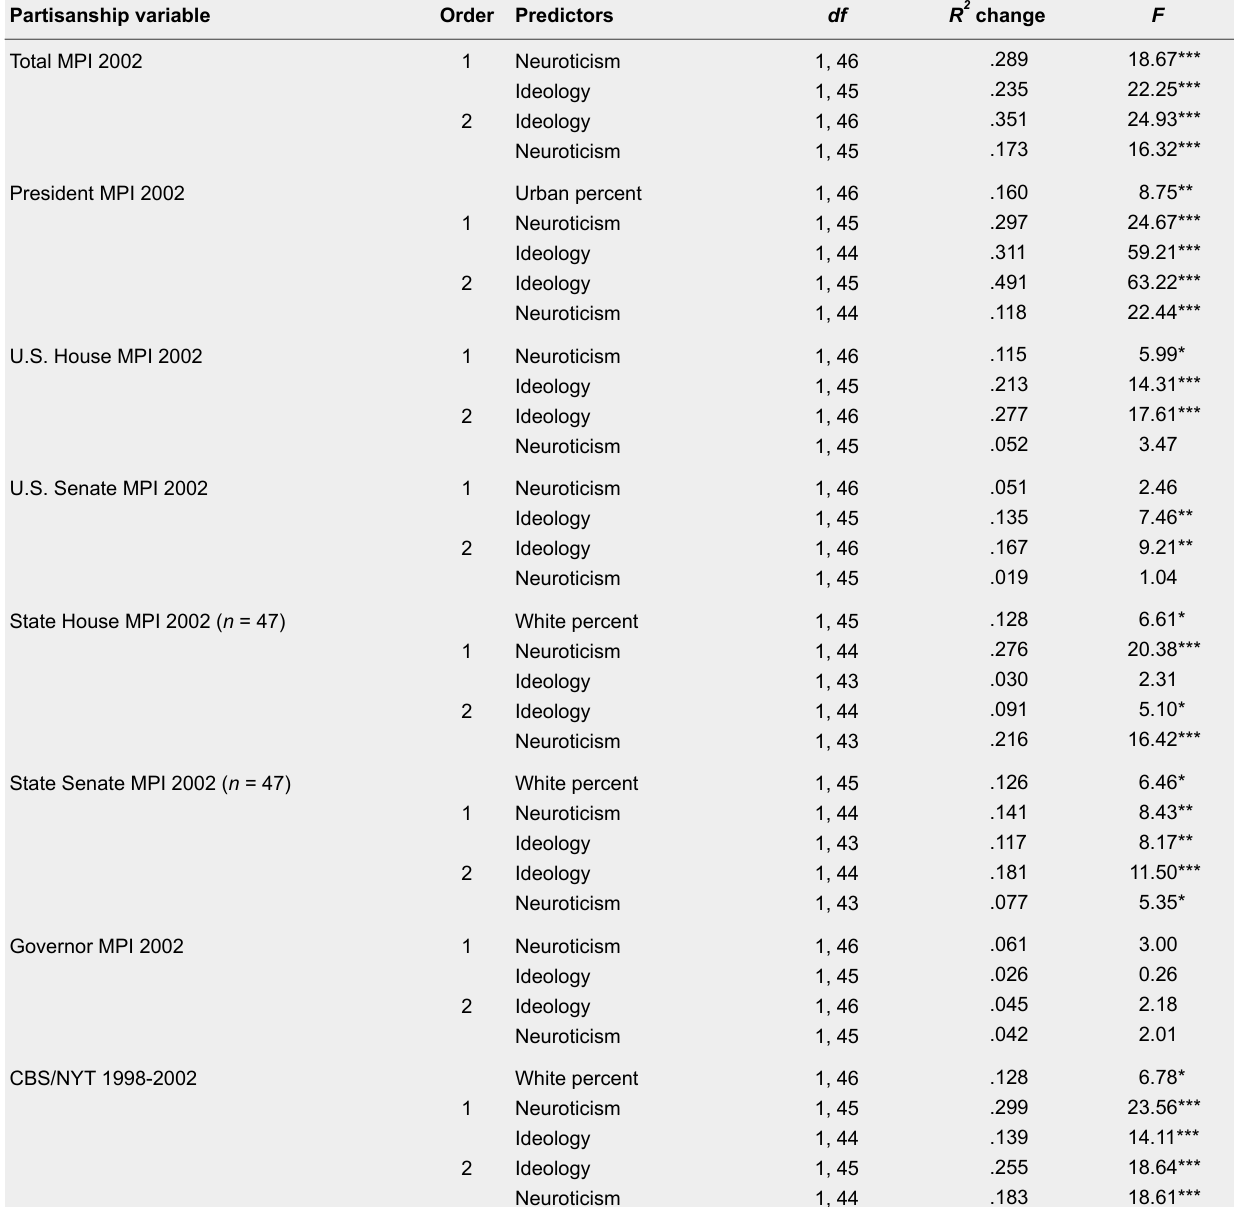
Results of Hierarchical Multiple Regression Equations with Partisanship as the Criterion Formed by Entering State SES, White Percent, and Urban Percent Stepwise Followed by Neuroticism and Ideology in Alternate Order Using 1998-2002 State Ideology Values (N =